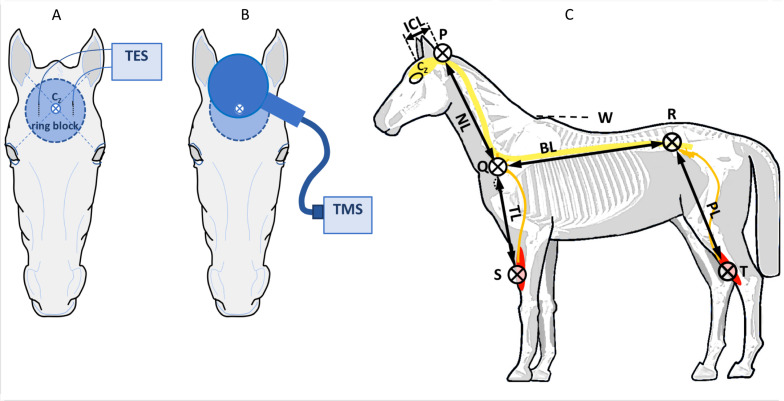
Placement of TES needle electrodes (A) and TMS coil (B) on the head of a horse. The vertex is defined at the cross-section of connecting lines between the ears and contralateral eyes. Circular area: ring block. (C) Anatomic landmarks for estimation of the axonal lengths in the spinal cord and peripheral nerves: P, occipital protuberance; Q, anterior rim of the scapula near corpus C7; R, dorso-ventral point of the hip; S, upper electrode ECR; T, upper electrode TC. ICL, intracranial segment length; NL, neck length 7 cervical corpora; BL, back length between Q and R; TL, length peripheral nerve limb; PL, length peripheral nerve hind limb.